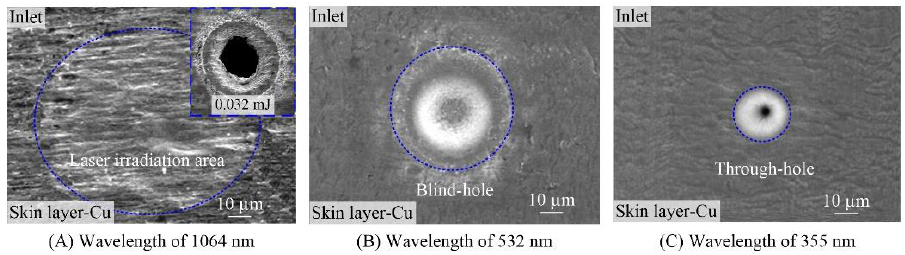
Figure 2. Effect of laser wavelengths on the holes in double-sided board (Energy of 0.005 mJ, 50 pulses).